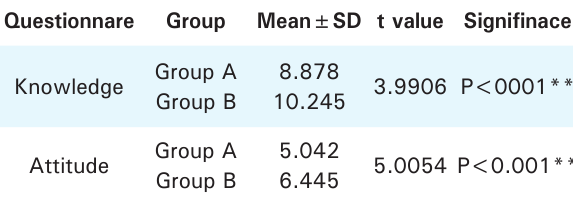
Table 2. Comparison of the scores of knowledge and attitude of the two groups using Student’s